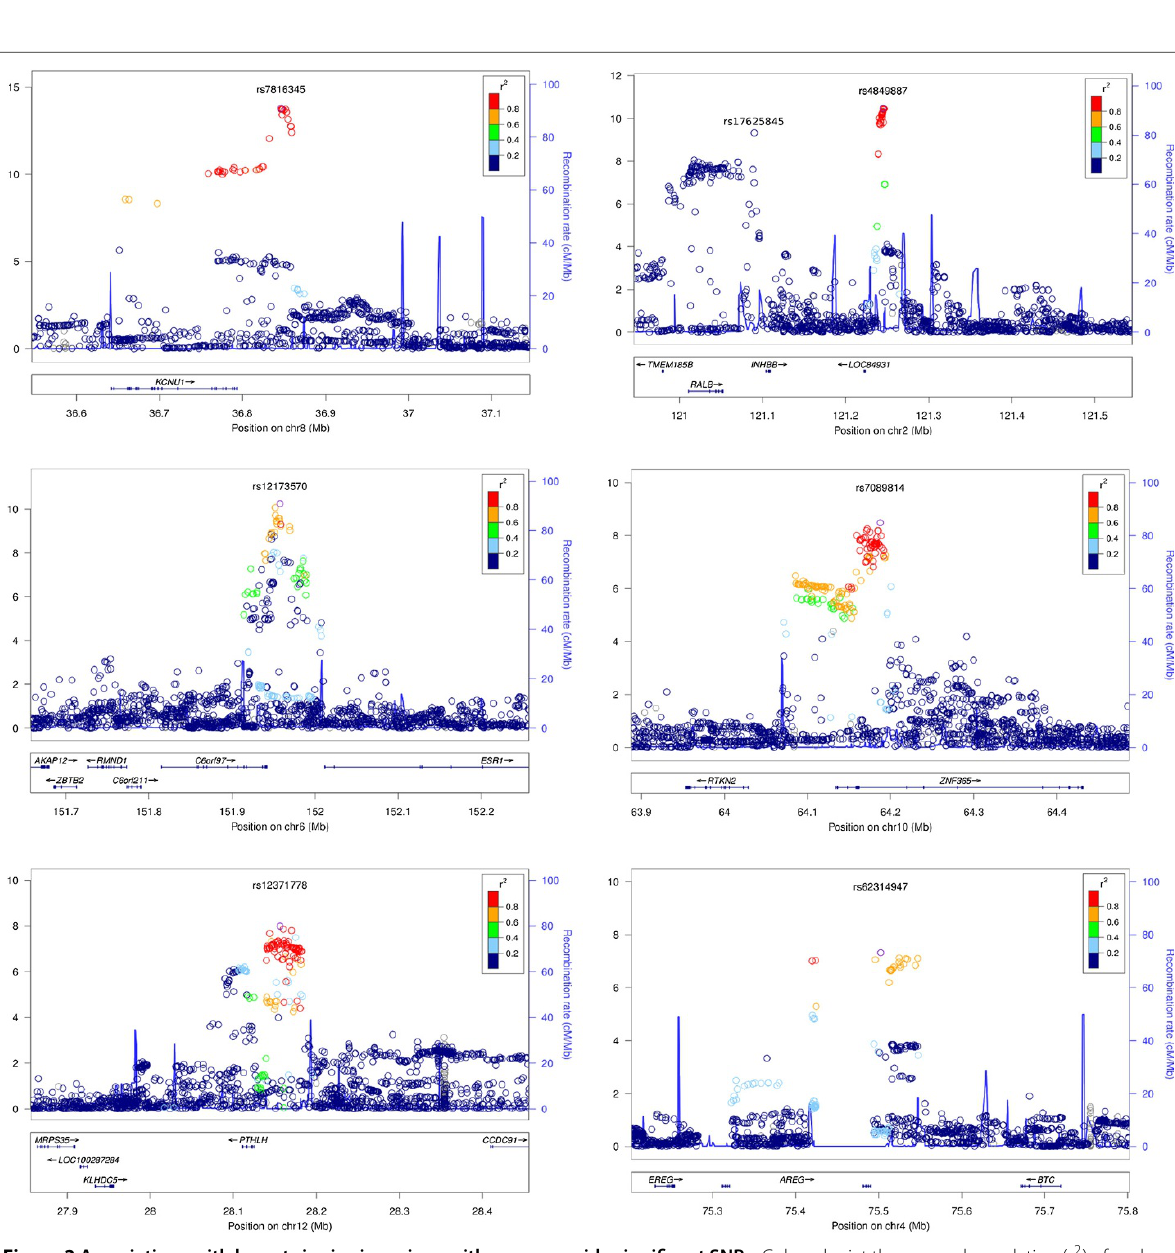
Figure 2 Associations with breast size in six regions with genome-wide significant SNPs. Colors depict the squared correlation ( r 2 ) of each SNP with the most associated SNP (which is shown in purple). Gray indicates SNPs for which r 2 information was missing. For the plot labeled with rs7816345, the gene ZNF703 lies about 400kb outside the region